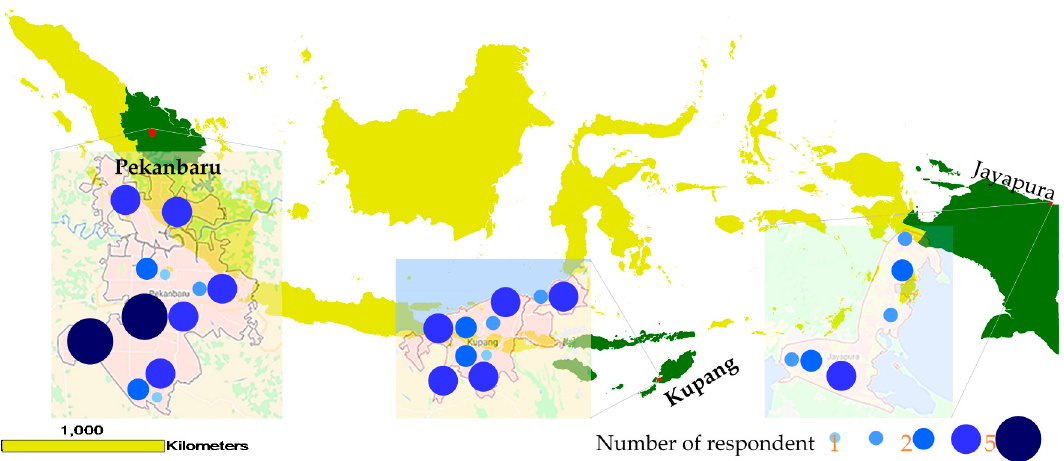
Figure 4. The distribution of respondents by city address in the study locations.